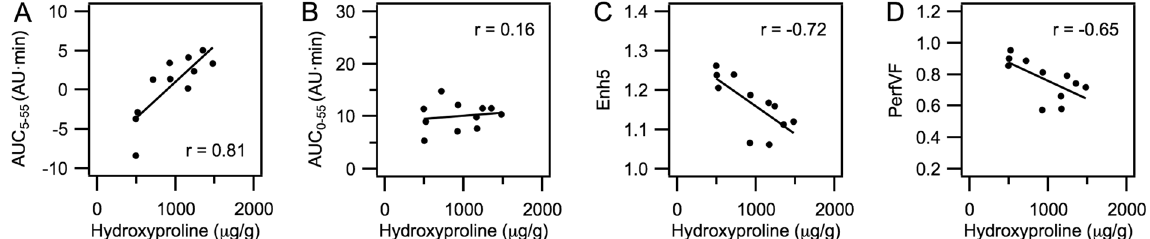
Figure 6. Correlations between total tissue collagen (hydroxyproline) and MRI measurements obtained with EP-3533 (n = 11). ( A ) Area under the curve with 5 min post-injection as reference (AUC 5–55 ); ( B ) area under the curve with the time of injection as reference (AUC 0–55 ); ( C ) MR signal enhancement at 5 min post-injection (Enh5); ( D ) volume fraction of tissue that is well perfused